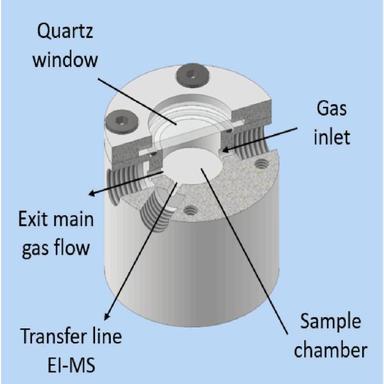
Construction drawing of the in-house-designed ablation cell for LA/EI-MS/ICP-OES.